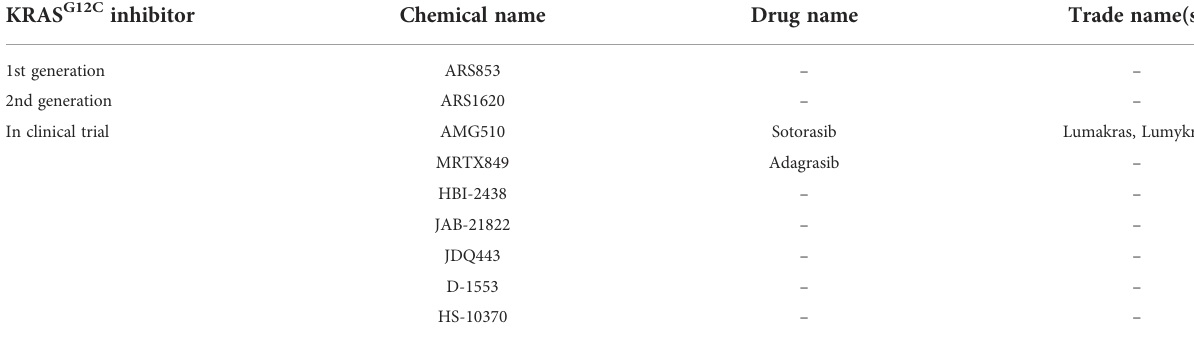
TABLE 1 KRAS G12C inhibitors. KRAS G12C